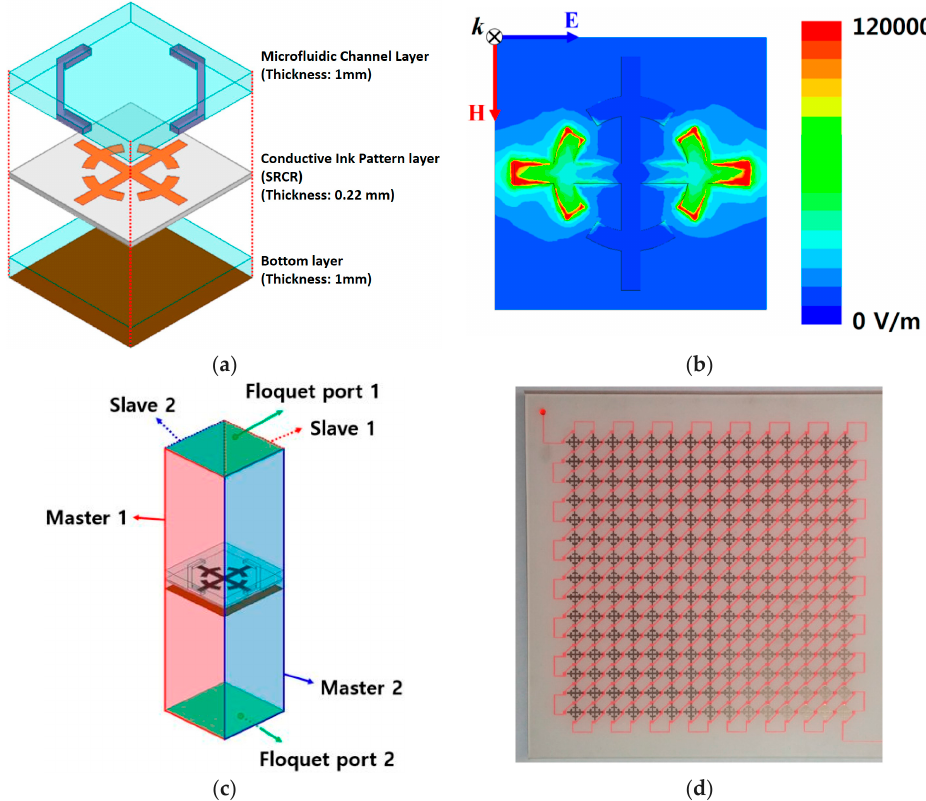
Figure 10. Flexible metasurface absorber is proposed as an ethanol sensor. SRCR is inkjet-printed on Kodak premium photo paper, serving as middle layer. Microfluidic channel is engraved on top layer (1 mm thick PDMS), and bottom PDMS layer is added to increase the absorbance. ( a ) Three-dimensional view of unit cell design; ( b ) electric field magnitude distribution of unit cell without loading a microfluidic channel; ( c ) simulation setup for boundary conditions and excitations; and ( d ) fabricated prototype filled with DI-water. Red ink is mixed with DI-water to make the fluidic path observable (redrawn from [48]).